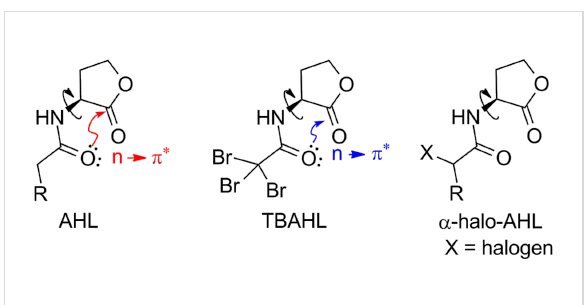
Figure 1: Structure of N -acyl homoserine lactone (AHL) and putative n →π * interaction. Attenuation of n →π * interaction in N -tribromoacetyl homoserine lactone (TBAHL) as suggested by Newberry and Raines [18]. General structure of compounds used in this study ( α